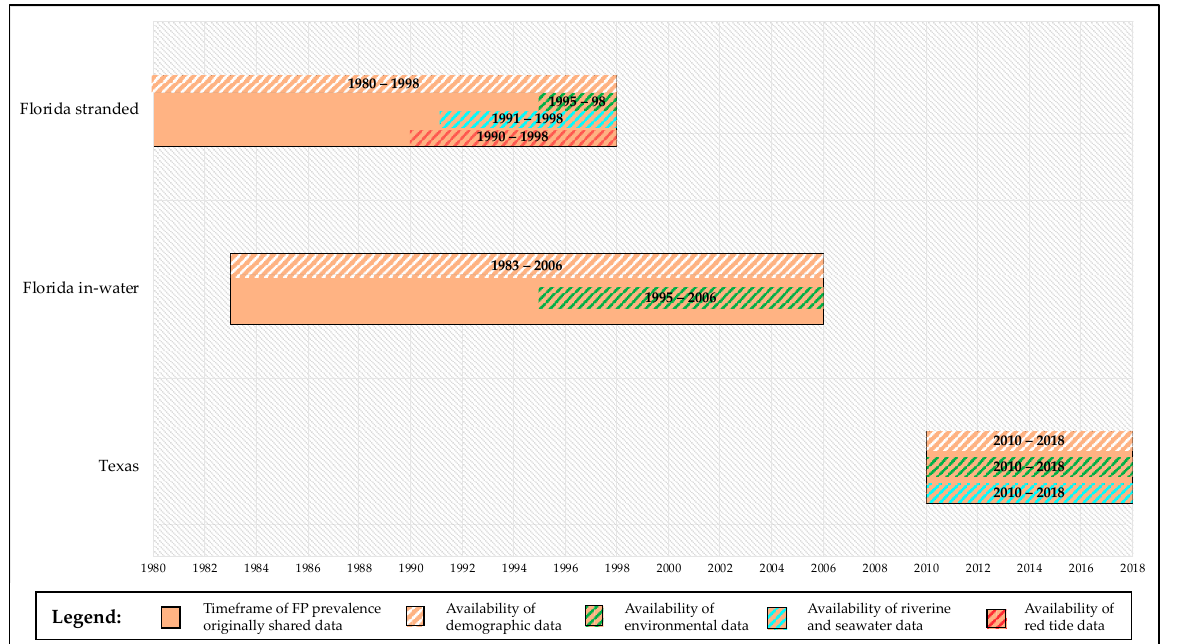
Figure 1. Timeframe of retrospective study. The orange blocks represent the timeframes of FP prevalence data shared by 3rd party authors or available in published papers for the different locations (1980–1998 for Florida stranded FP dataset [20]; 1983–2006 for Florida in-water FP dataset [50,51]; 2010–2018 for Texas FP dataset [14]). Matching timeframe of availability of predictor variables is reported for each group. Absence of predictor variables block in a given location (i.e., red tide data in Florida in-water locations) corresponds to NAs. Not all FP data could be utilized for the purposes of our study. Statistical analyses were run solely on the space and time matching timeframes from the earliest available timeframe after demographic data availability (i.e., patterns of Florida in-water FP prevalence versus environmental and demographic predictors from 1995 to 2006, see Section 2.2.1).